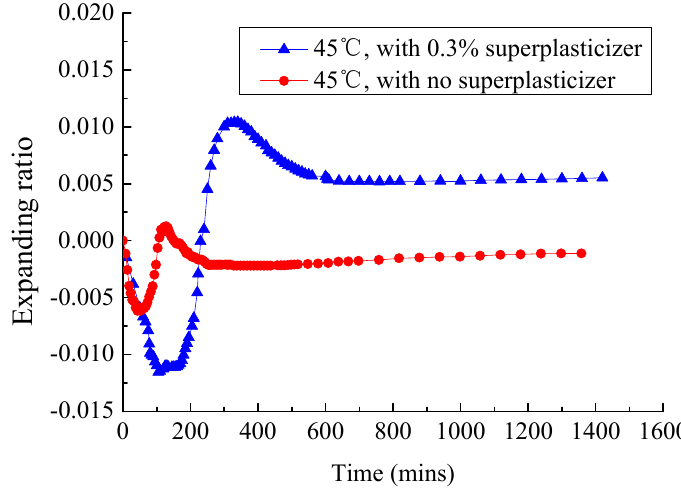
ff ect of superplasticizer on the expansion ratio of CAM I Figure 15. Effect of superplasticizer on the expansion ratio of CAM I paste. Figure 15. E Figure 15. Effect of superplasticizer on the expansion ratio of CAM I paste.